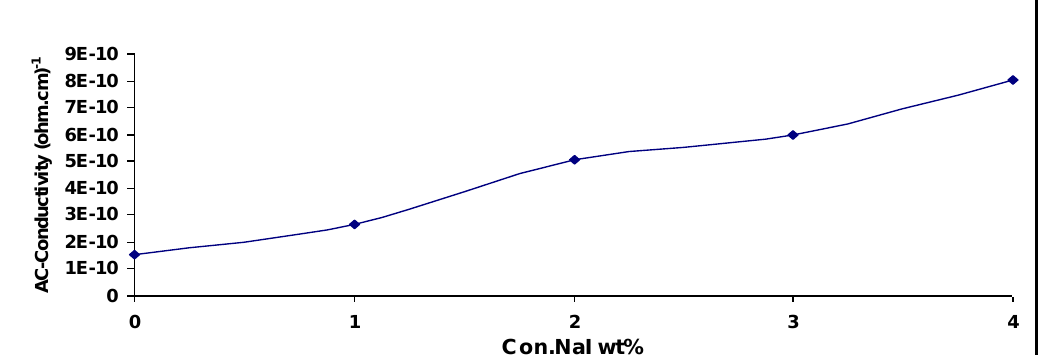
Fig.3 : AC conductivity for PVA- NaI composites with angular frequency.